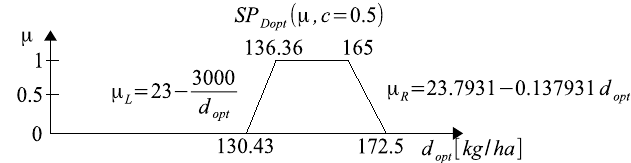
Figure 37. The average T1MF ( µ , c = 0.5) of all possible cuts of SP Dopt